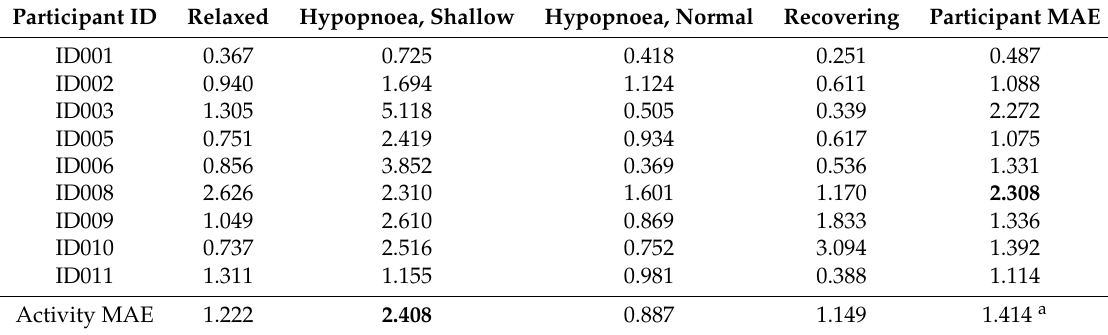
Table 6. Mean absolute error for respiration rates with respect to activity and participant.